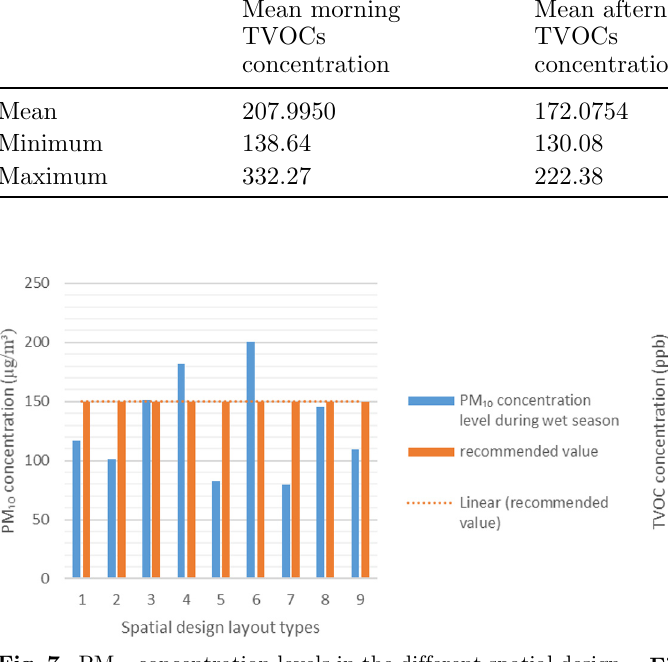
Fig. 8. TVOC concentration levels in the different spatial design layouts during dry